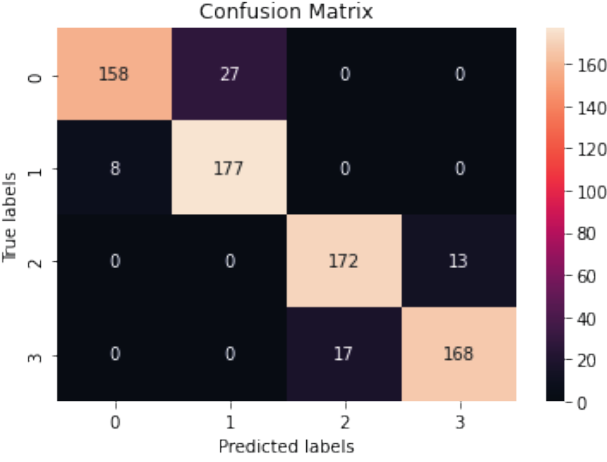
Fig. 6. Confusion matrix obtained in the test set of the created neural